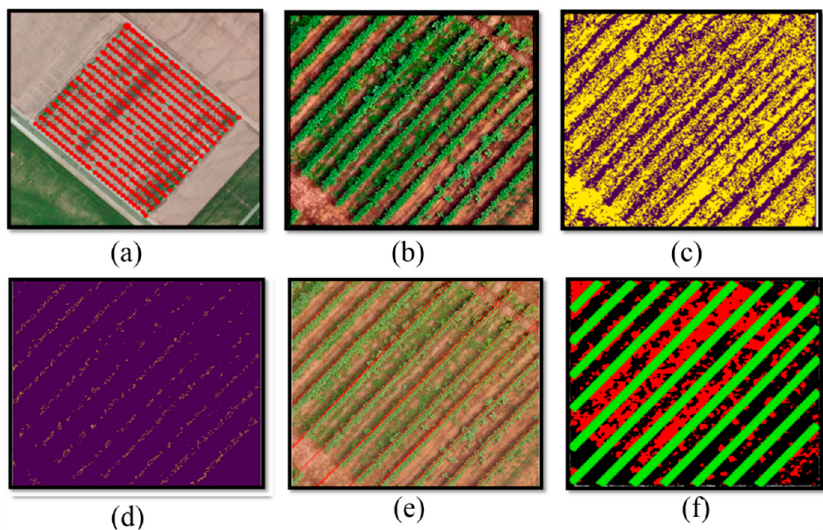
Figure 4. Various stages of image pre-processing: ( a ) Loading raw images in Pix4D software for mosaicking, ( b ) Clipping RGB imagery pertaining to each 10 m × 10 m treatment plot, ( c ) Otsu-thresholding, ( d ) Applying canny-edge algorithm and median filtering, ( e ) Generating Hough lines over the RGB imagery, and ( f ) Creating strips around Hough lines (green lines); here red pixels represent inter-row weeds and black pixels represent soil/shadows.